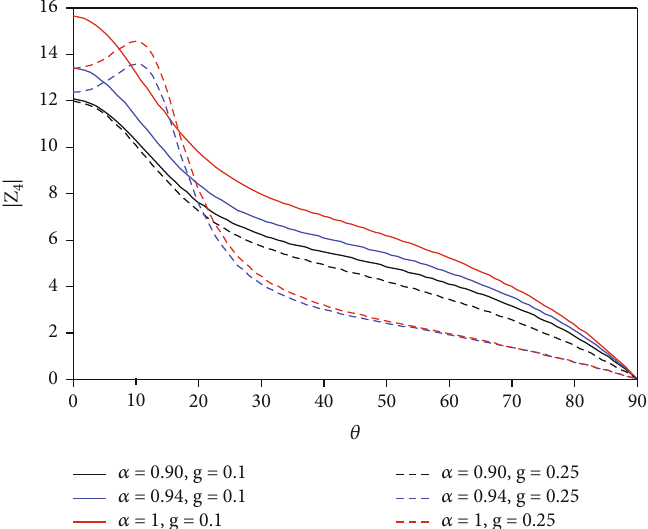
j concerning the angle of incidence θ for various values of the fractional parameter of the 4